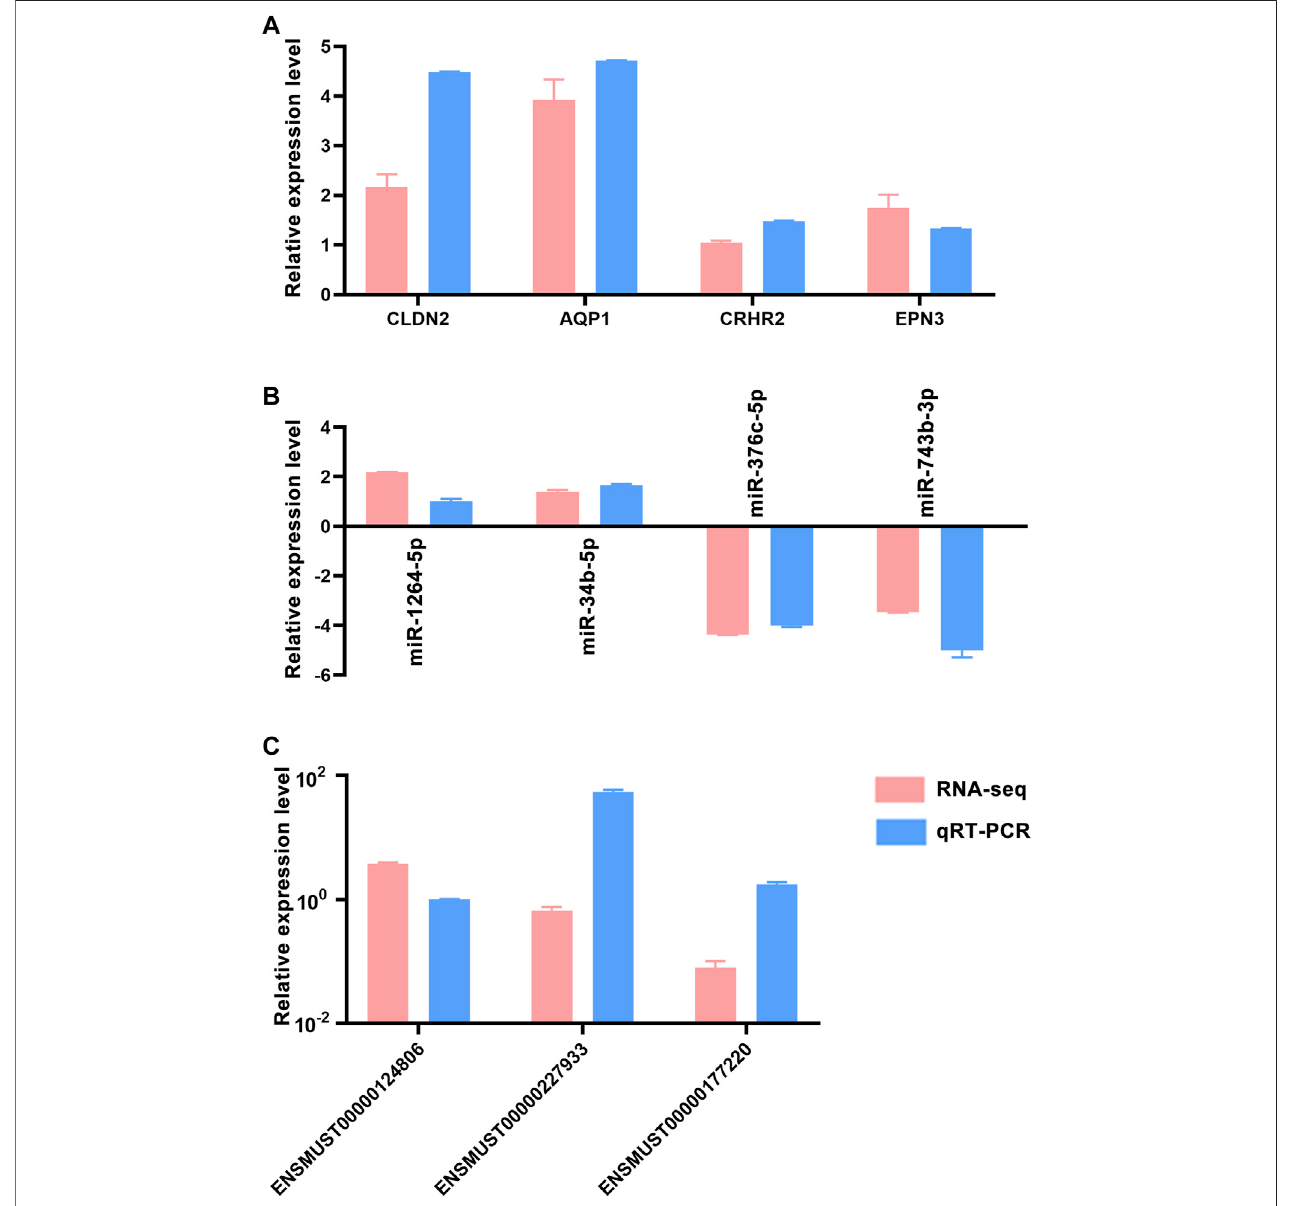
FIGURE 4 | qRT-PCR validation of dysregulated RNAs. Comparison of log2 fold changes in mRNAs (A) , miRNAs (B) and lncRNAs (C) between RNA-Seq and qRT-PCR results. Error bars represented standard error of mean (SEM) ( n = 5).